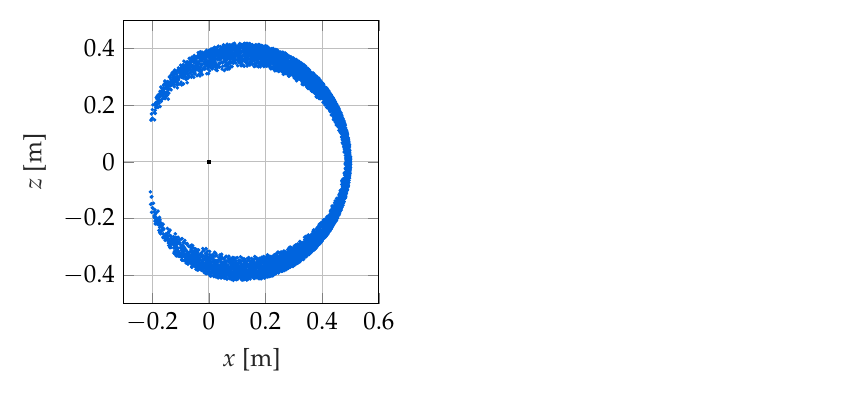
Figure 5. Empirically determined workspace of the kinematic controller for N max = 20N.